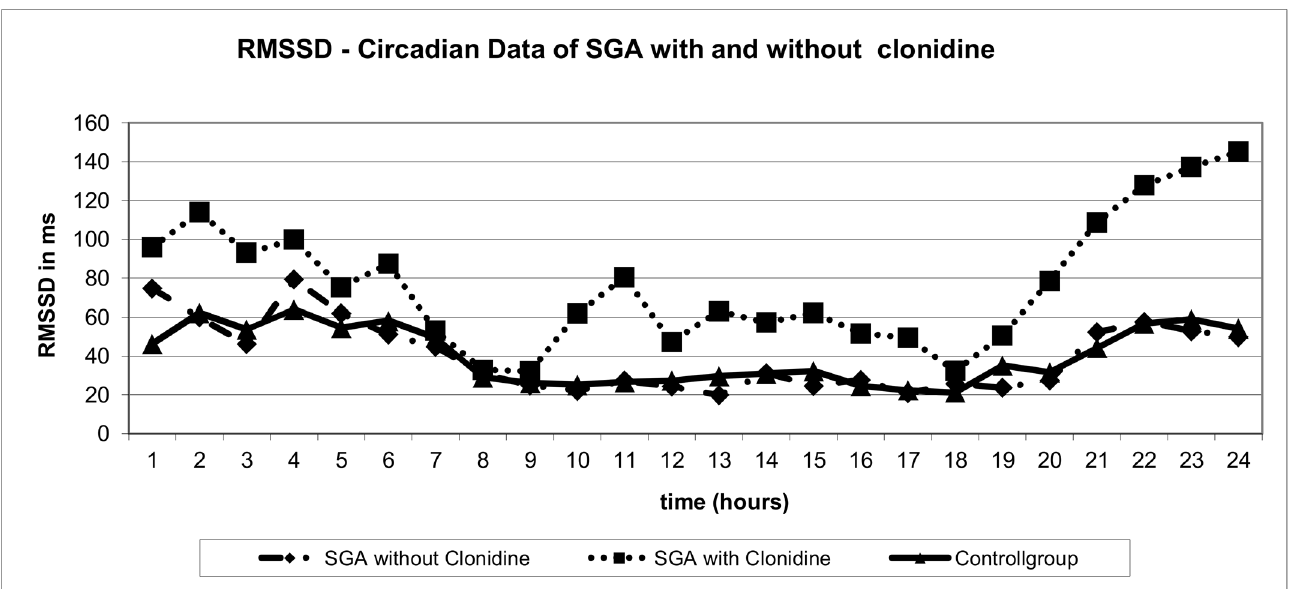
Fig 3. rMSSD-Circadian Data of SGA with and without clonidine. Effect of clonidine given at 9:00 a.m. on the vagus parameter rMSSD in children with SGA (n = 6) after clonidine administration ( ■ ) compared to age-matched SGA without clonidine ( ♦ ) and to age-matched healthy controls ( ▲